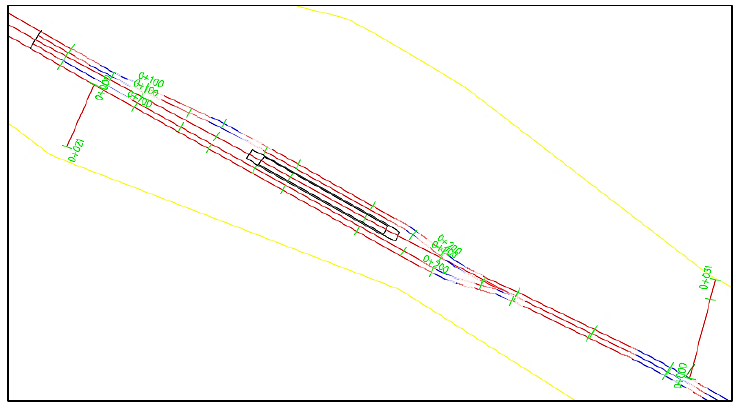
Figure 4. Tramway and road track modeling.